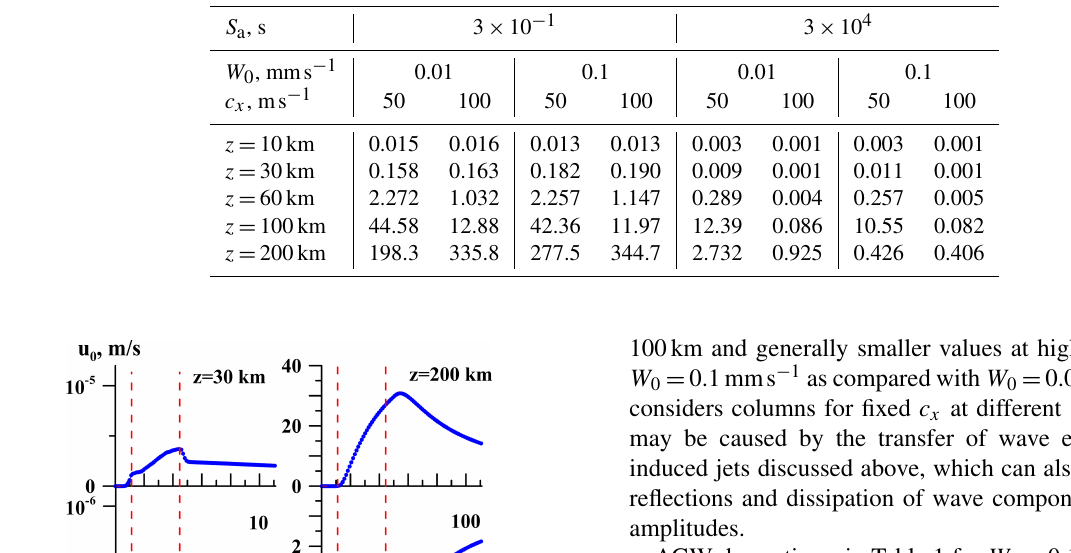
Table 2. Ratios δw ( z ) /W 0 at t = 170h at different altitudes for various parameters of the surface wave source (Eq. 5) and its time dependence (Eq. 7).